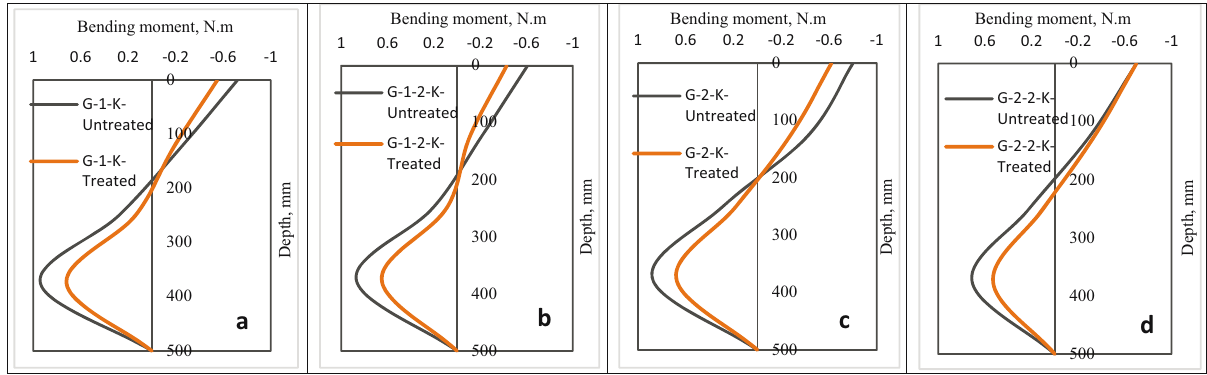
Figure 6: Bending moment of the pile group in the treated and untreated soil with nano - clay – P1 at ( a ) 50% axial load, ( b ) 50% axial load and 100% lateral load, ( c ) 100% axial load, and ( d ) 100% axial load and 100% lateral load.